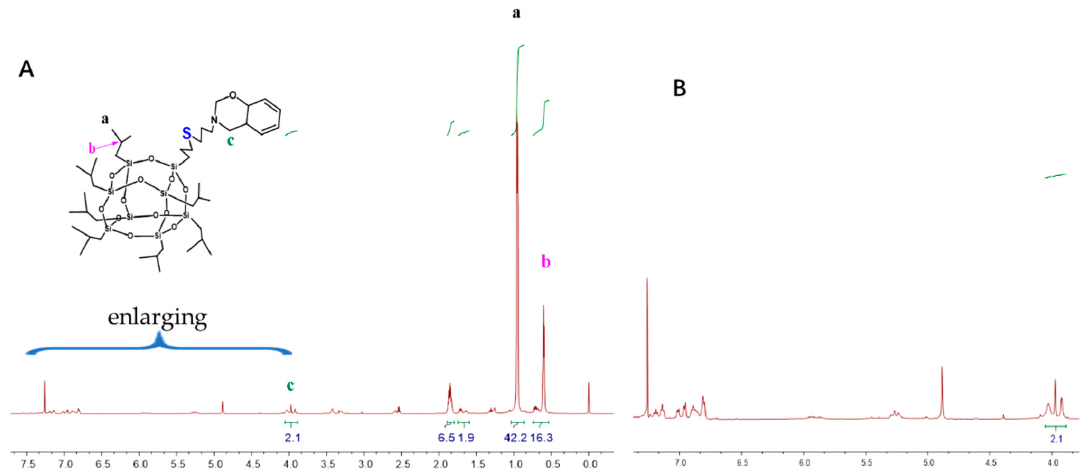
Figure 5. ( A ) 1 H NMR spectra of SPOSS-BOZ and ( B ) enlarged view between 4.0 and 7.5 of